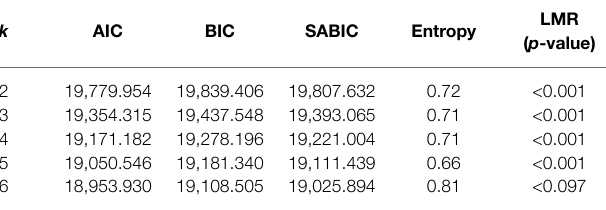
TABLE 3 | Model comparison for different profile